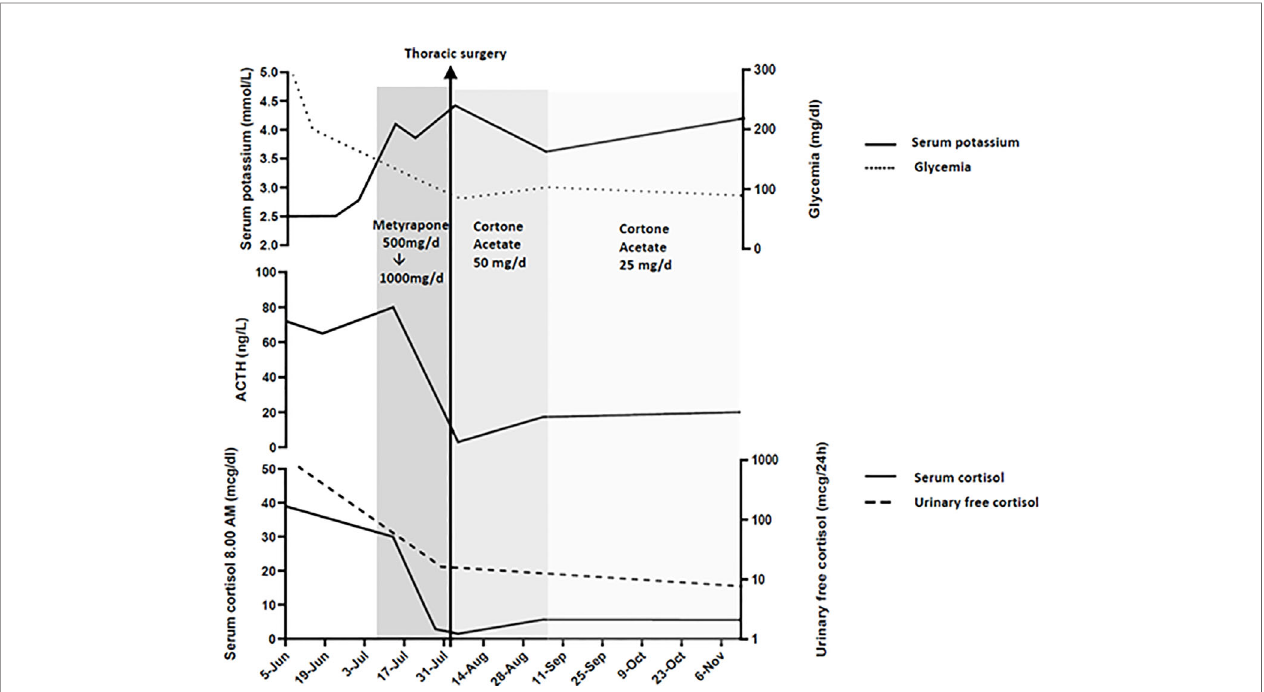
FIGURE 1 | Serum cortisol, ACTH, glycemia, potassium and urinary free cortisol levels at presentation, during medical therapy and after thoracic